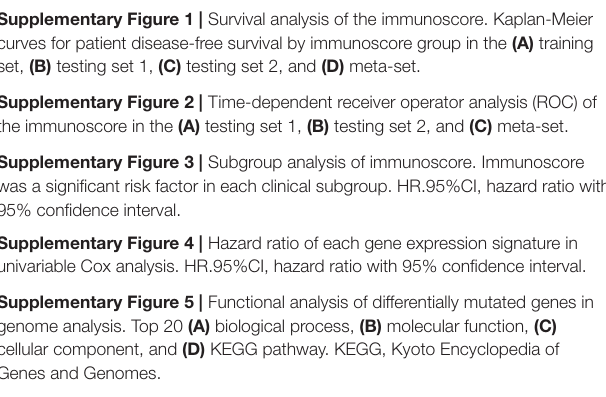
Supplementary Figure 1 | Survival analysis of the immunoscore. Kaplan-Meier curves for patient disease-free survival by immunoscore group in the (A) training set, (B) testing set 1, (C) testing set 2, and (D) meta-set. Supplementary Figure 2 | Time-dependent receiver operator analysis (ROC) of the immunoscore in the (A) testing set 1, (B) testing set 2, and (C) meta-set. Supplementary Figure 3 | Subgroup analysis of immunoscore. Immunoscore was a significant risk factor in each clinical subgroup. HR.95%CI, hazard ratio with 95% confidence interval. Supplementary Figure 4 | Hazard ratio of each gene expression signature in univariable Cox analysis. HR.95%CI, hazard ratio with 95% confidence interval. Supplementary Figure 5 | Functional analysis of differentially mutated genes in genome analysis. Top 20 (A) biological process, (B) molecular function, (C) cellular component, and (D) KEGG pathway. KEGG, Kyoto Encyclopedia of Genes and